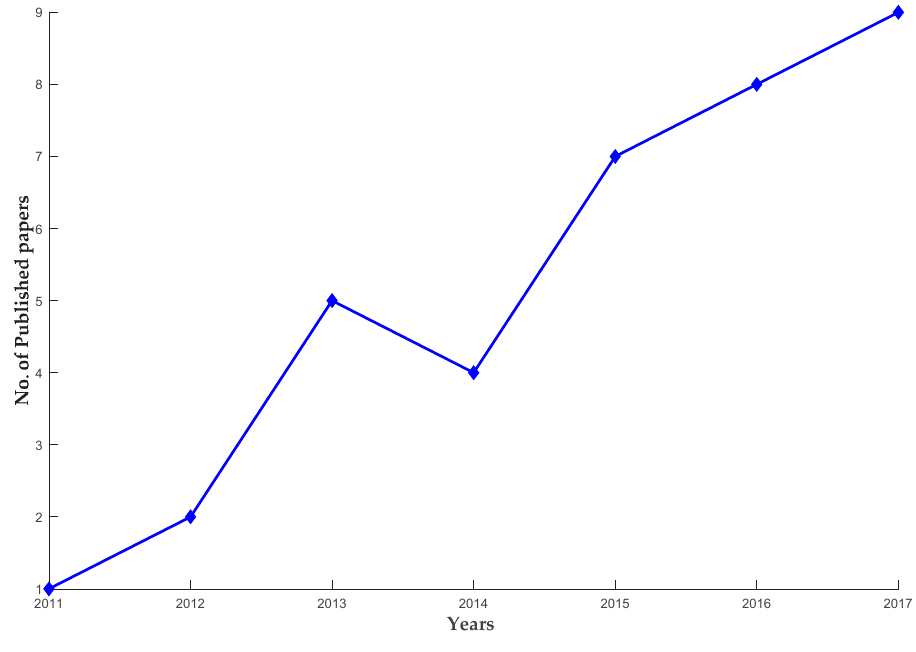
Figure 3. Publication distribution by year.